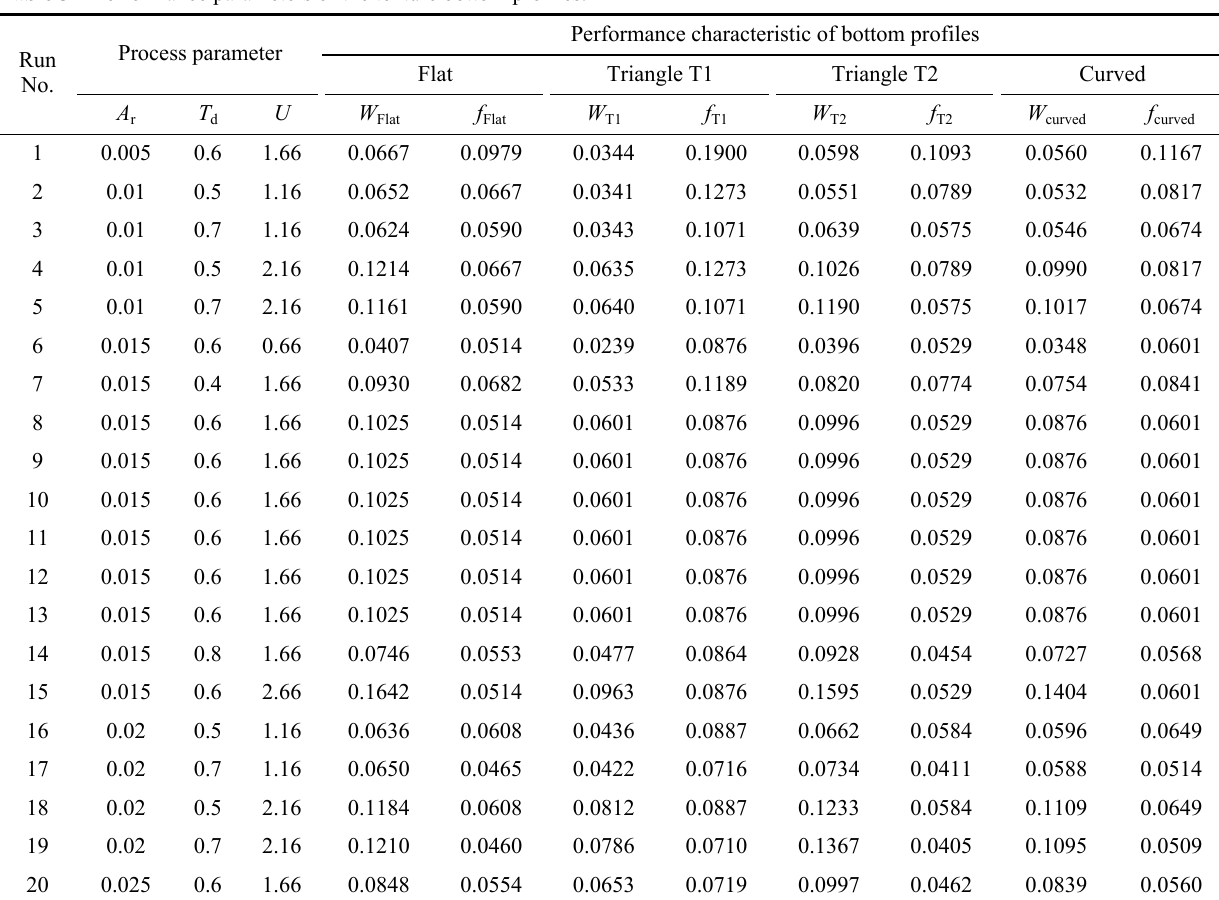
Table 3 Performance parameters of the texture bottom